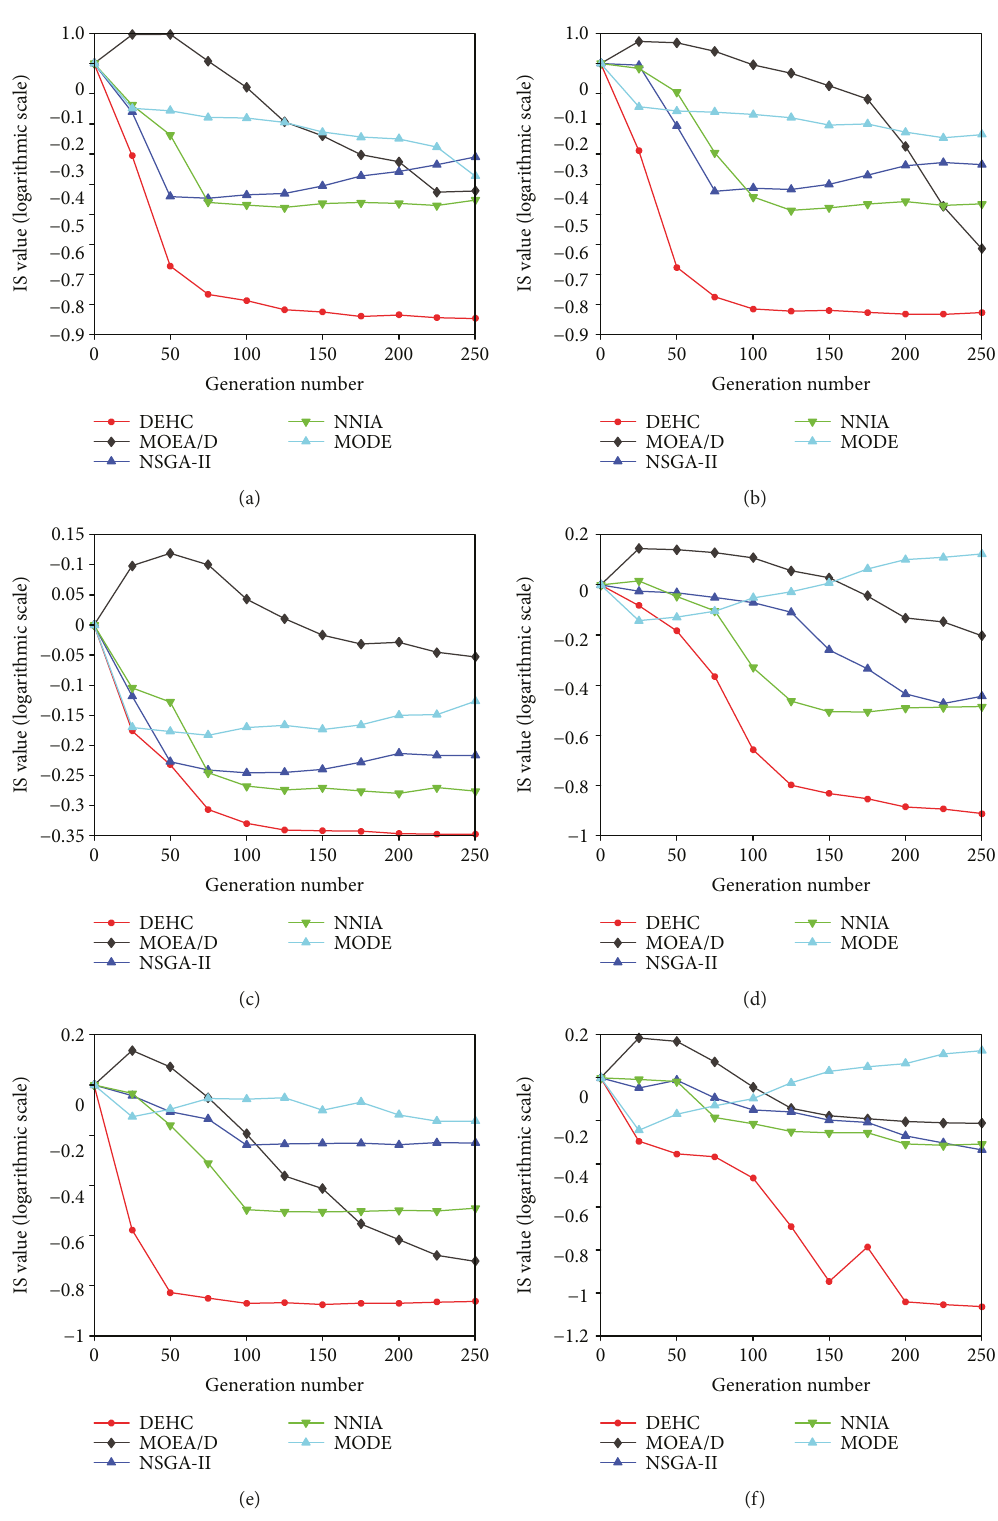
Figure 6: Median IS values versus the evolution time. (a) DTLZ2, (b) DTLZ3, (c) DTLZ4, (d) DTLZ5, (e) DTLZ6, and (f)